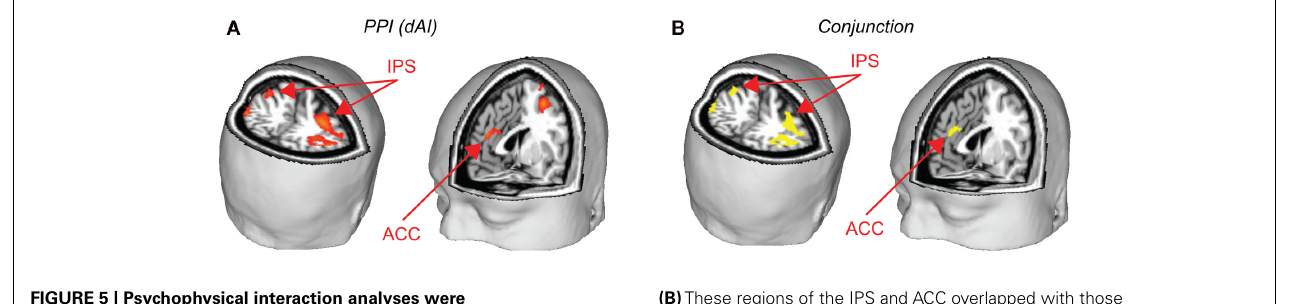
FIGURE 5 | Psychophysical interaction analyses were performed to determine how the dAI interacts with brain areas related to decision-making. (A) Using the peak voxel of dAI as the seed, the IPS and ACC were identified as regions with higher functional connectivity to the dAI during risky versus safe choices.